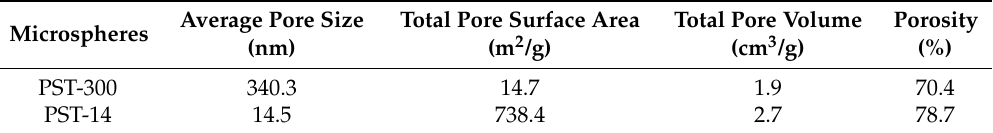
Table 1. Structural data of PST-300 and PST-14